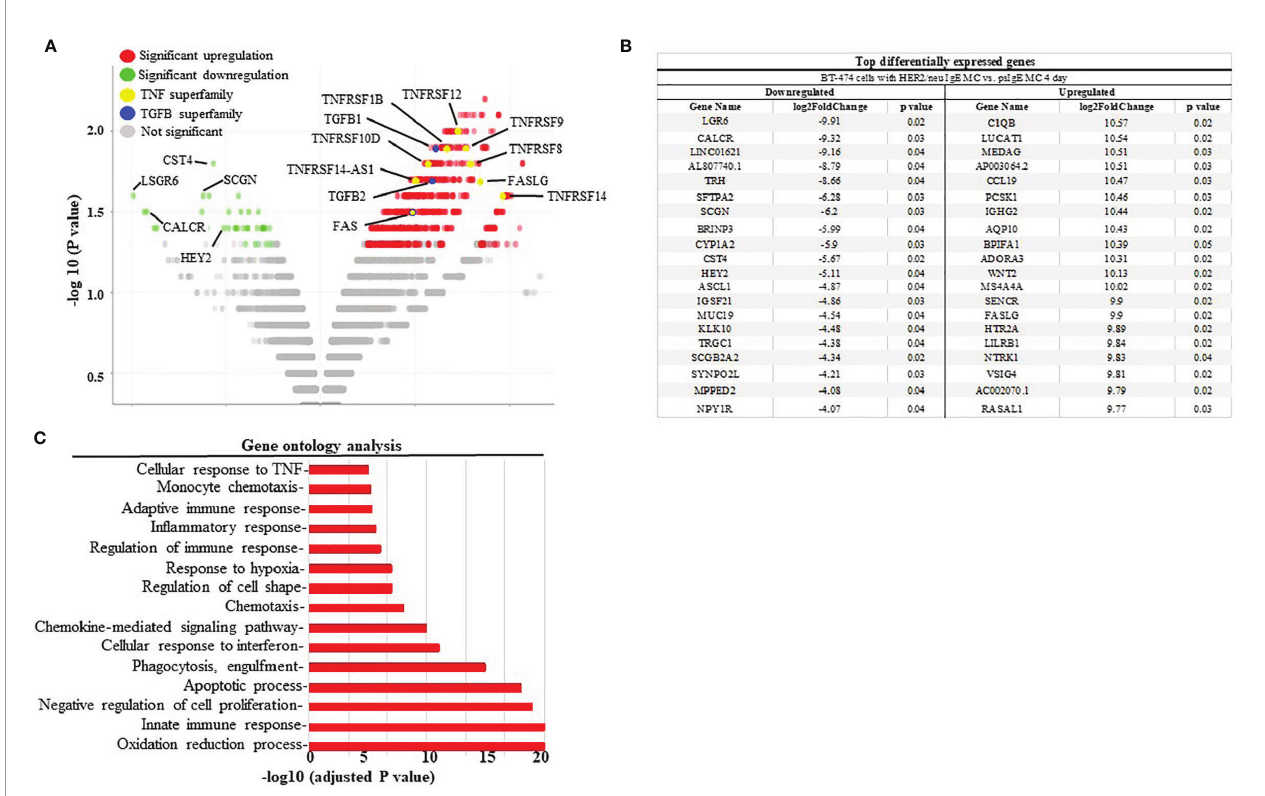
FIGURE 4 | Differential gene expression analysis BT474-1261 cells treated of HER2/ neu IgE-sensitized vs. non-speci fi c IgE-sensitized ADMC. (A) Volcano plot of global transcriptional changes of BT474-1261 cells treated with ADMC sensitized HER2/ neu IgE vs ADMC sensitized psIgE. Each data point in the scatter plot represents a gene. The ADMC were from male donors so that they could be distinguished from BT474-1261 cells by Y-chromosome gene mapping. Red and green indicate signi fi cant (P < 0.05) differences in control vs. treated cells. The log2 fold change of each gene is represented on the x-axis and the log10 of its adjusted p-value is on the y-axis. Genes with an adjusted p-value less than 0.05 and a log2 fold change greater than 1 are indicated by red dots (upregulated genes). Genes with an adjusted p-value less than 0.05 and a log2 fold change less than -1 are indicated by green dots (downregulated genes). (B) Top genes signi fi cantly affected by HER2/ neu vs control ADMC. (C) Gene ontology analysis. Signi fi cantly (adjusted P-value <=0.05) differentially expressed genes were clustered by their gene ontology and the enrichment of gene ontology terms were tested using Fisher exact test (GeneSCF